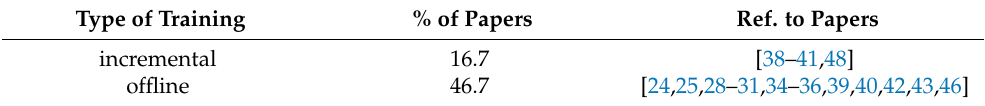
Table 11. Incrementality of learning procedures. Type of Training % of